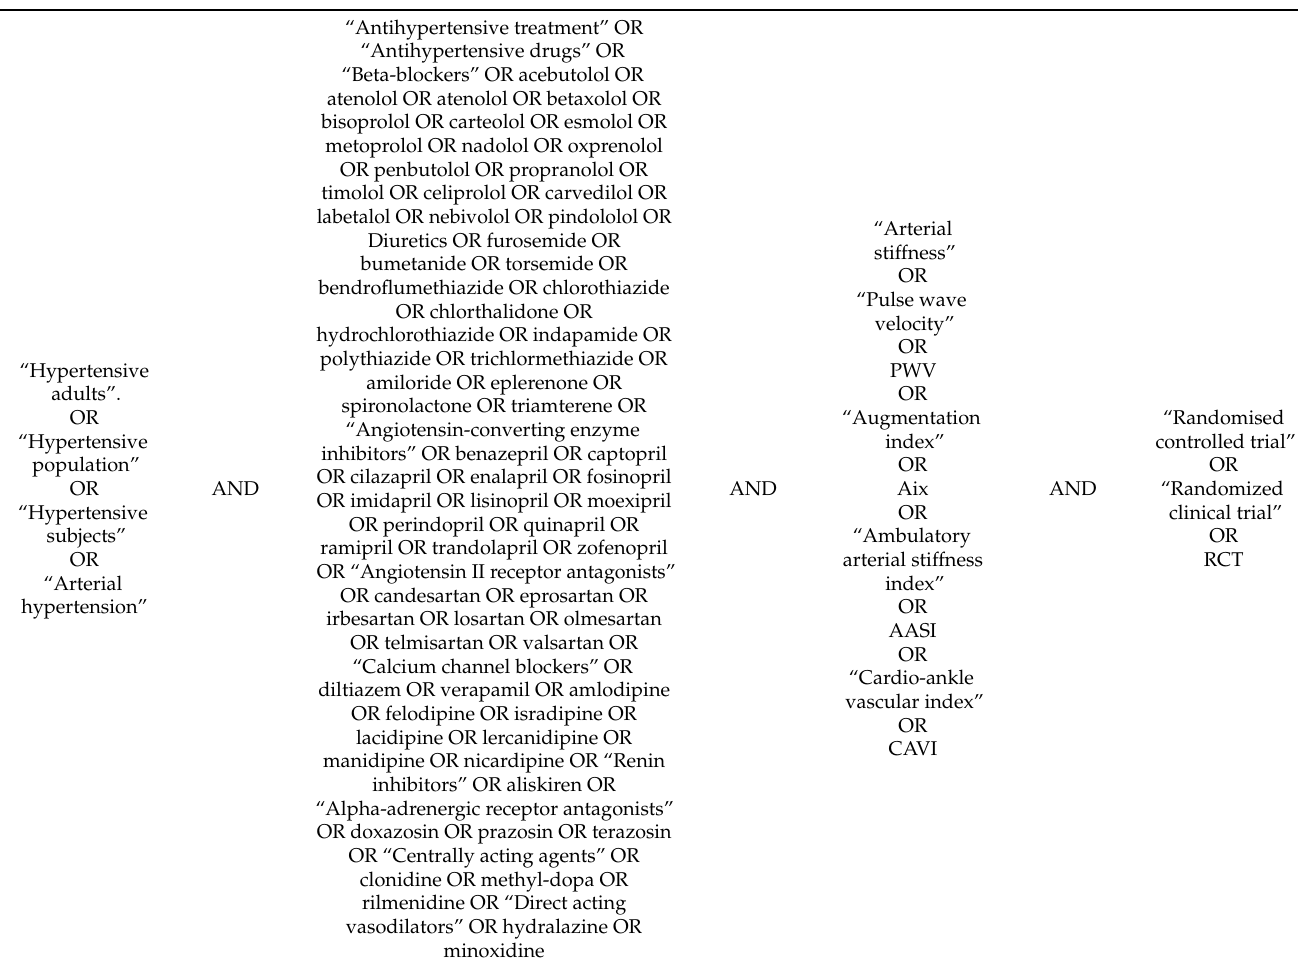
Table 1. MEDLINE search strategy.